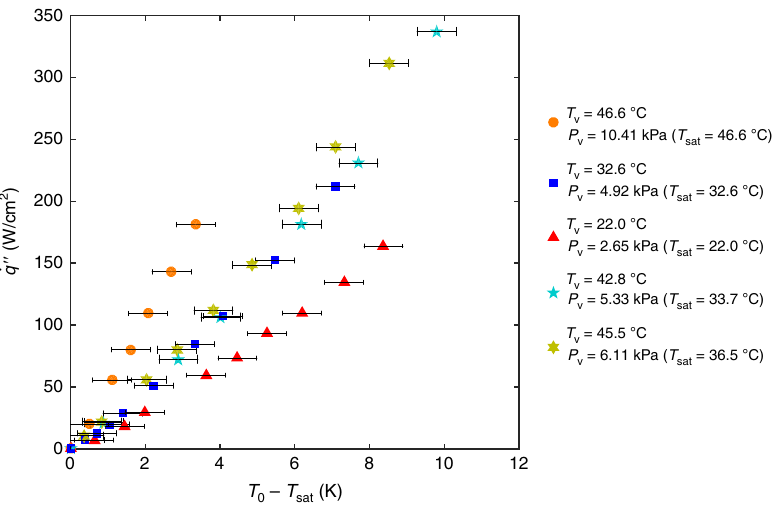
Fig. 4 Experimental results of q ̇ ″ as a function of T 0 − T sat for select working conditions. The red triangles, dark blue squares, and orange circles represent the experimental data in saturated vapour for P v = 2.65 kPa with T v = T sat = 22.0 °C, P v = 4.92 kPa with T v = T sat = 32.6 °C, and P v = 10.41 kPa with T v = T = 46.6 °C, respectively. The light blue pentagrams are for T sat C, P v = 6.11 kPa with T sat = 36.5 °C. Note that the light blue pentagrams are also for a sample with a different porosity ( ≈ 0.23) and pore diameter ( ≈